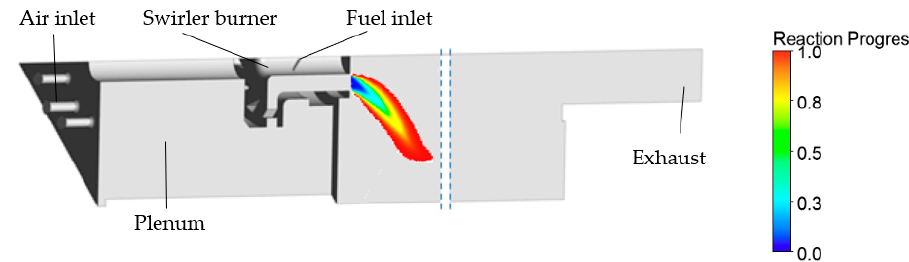
Figure 3. CFD domain of the DESIRE combustor.